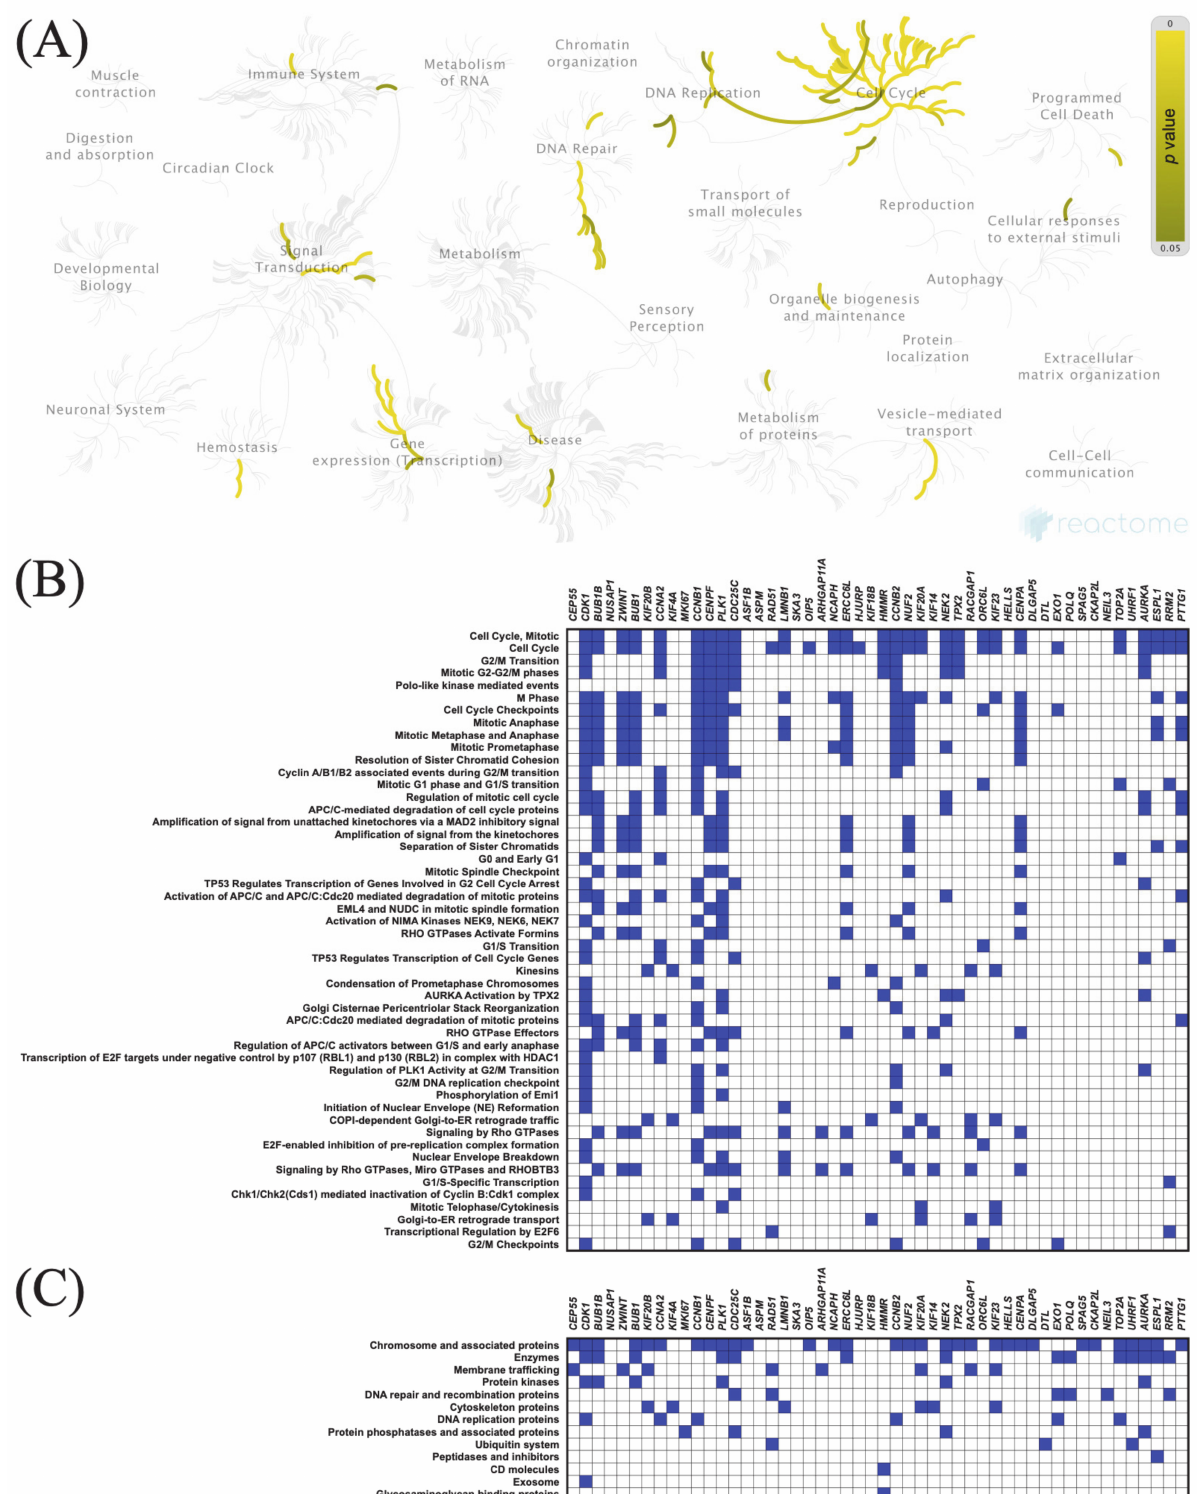
Figure 5. Functional enrichment analysis based on the TCGA dataset and UALCAN web tool. ( A , B ) The top 50 genes and Reactome pathways positively correlated with KIF11 expression; ( C ) BRITE functional hierarchies for the top 50 genes that were co-upregulated with KIF11